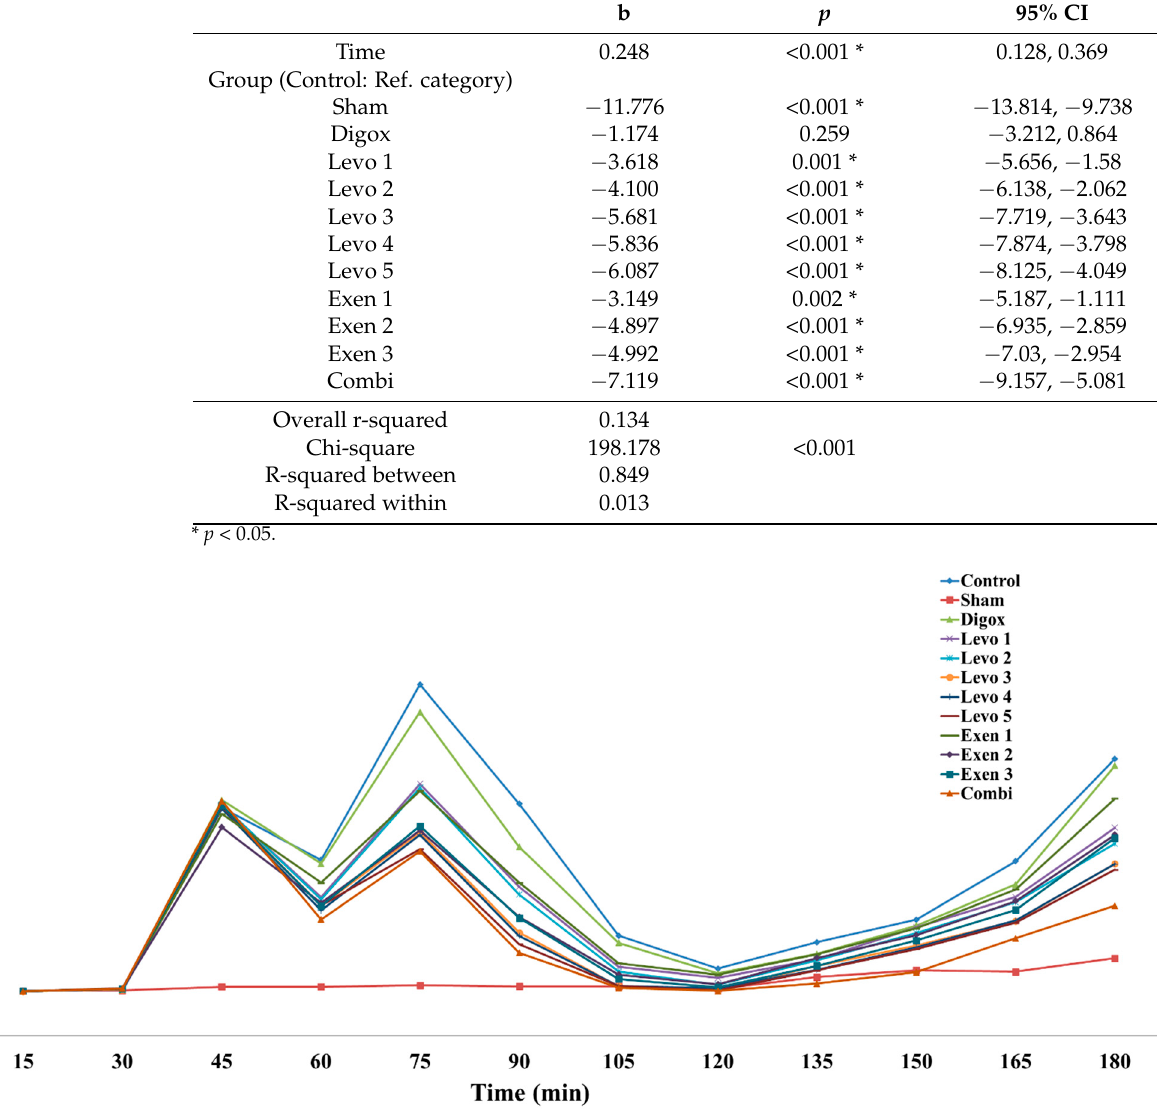
Figure 4. Changes in LVEDP across groups over